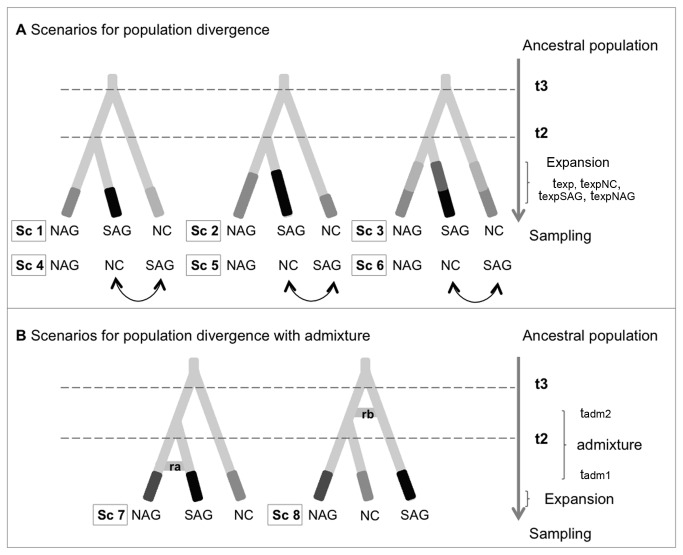
Competing scenarios of C. hominivorax regional group divergence and admixture.A: Sc1-Sc6: Divergence without admixture scenarios. B: Sc7-Sc8: NAG and SAG population admixture scenarios. NC: North and Central America group. NAG: North Amazon region group. SAG: South Amazon region group. t2 and t3: divergences times. ra, rb and rc: rates of admixture. texp: expansion times. The different colors and widths of lines represent the effective sizes of different populations.